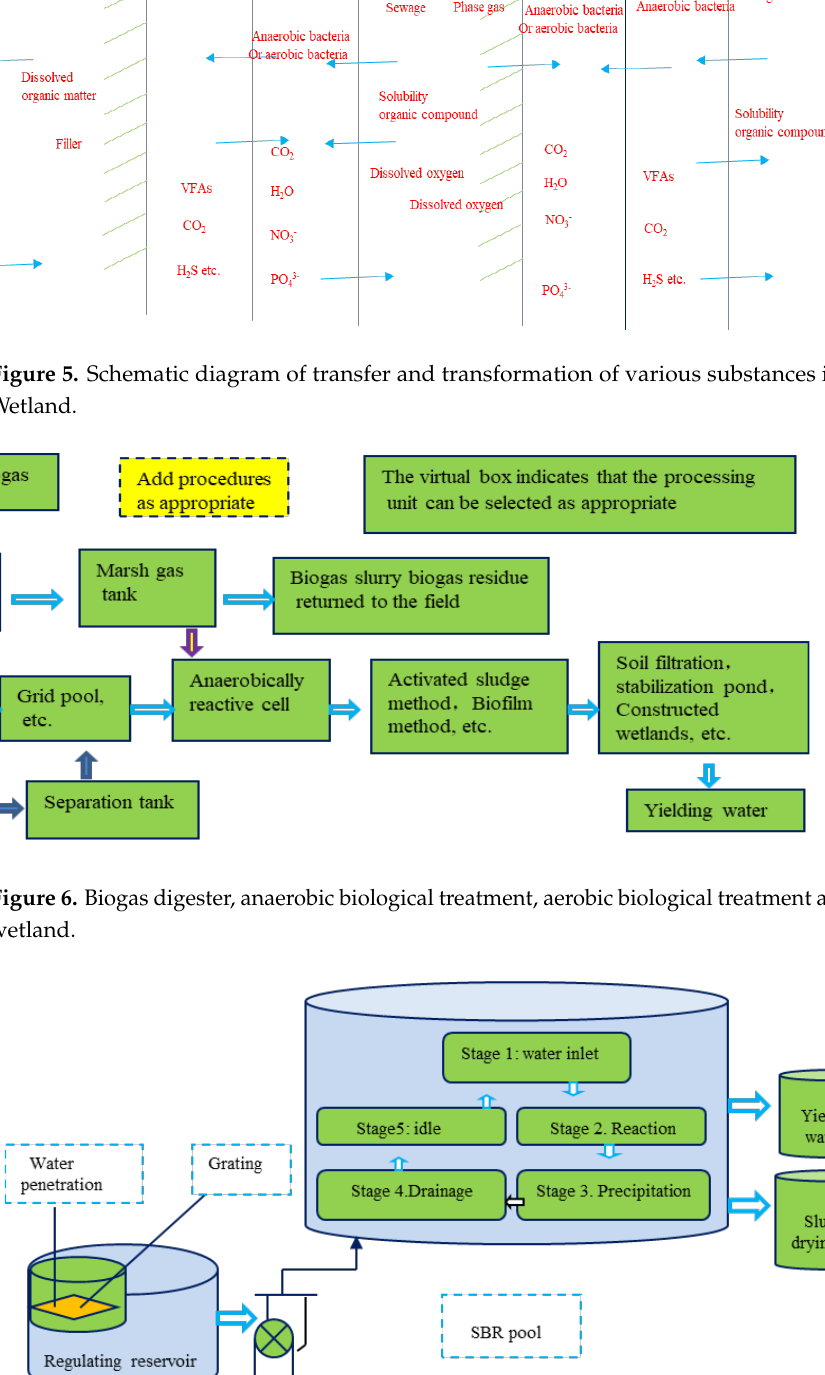
Figure 7. Integrated complete equipment process.